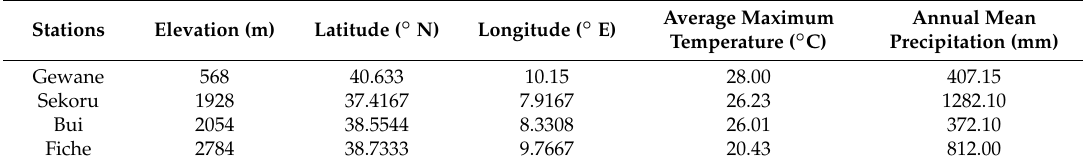
Table 1. Basic information of meteorological stations.